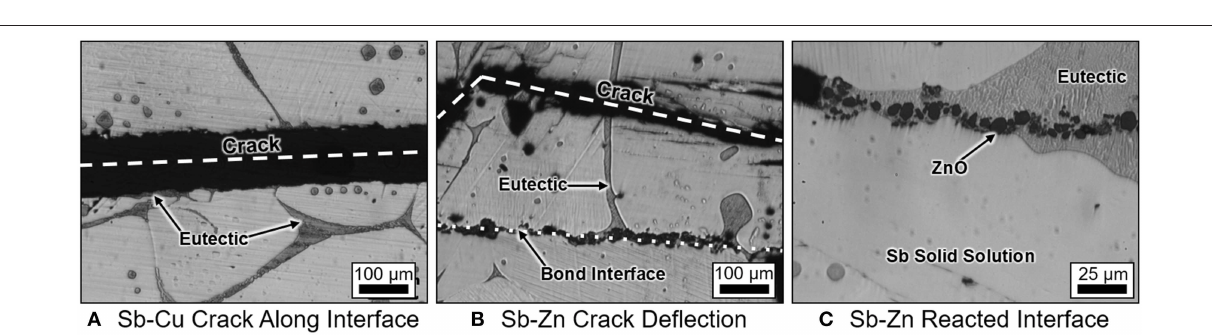
FIGURE 7 | Images of (A) Sb-Cu and (B) Sb-Zn showing top view the chevron notch fracture surface after bonding heat treatment and subsequent fracture toughness testing. The dashed lines show the entire area of the chevron notch, whereas the solid white line shows the end of the bond, and hence fracture, area.